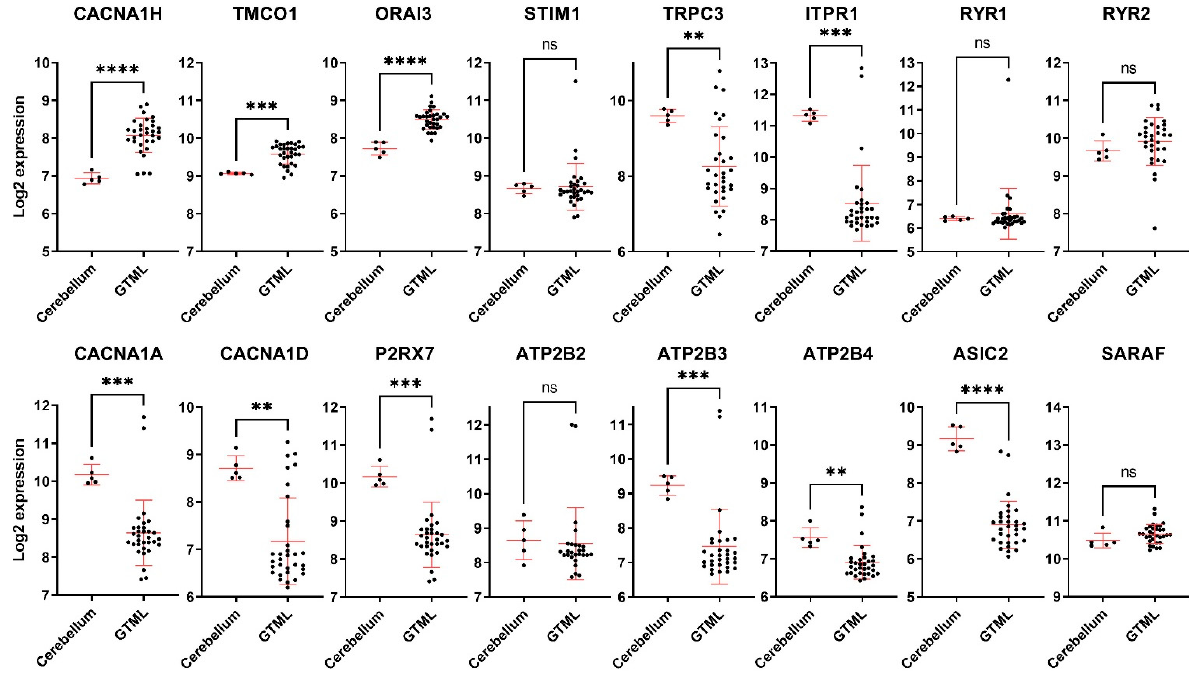
Figure 5. Expression of the dysregulated Ca 2+ transporter genes in GTML mice. mRNA expression (in log2) of 5 normal cerebellum and 32 MB tumours from the GTML mouse model, sourced from the GEO dataset with accession number GSE36594. ns: not significant p > 0.05, ** p < 0.01, *** p < 0.001, **** p -value < 0.0001, two-tailed unpaired non-parametric t - test, with Mann Whitney test, mean with SD.